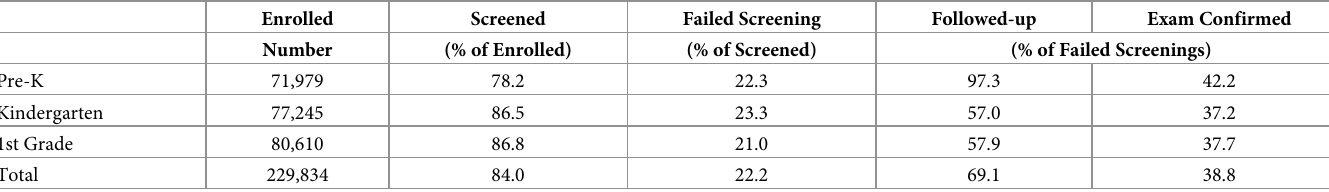
Table 2. Rates of screening, failed screening, follow-up, and confirmed exams in Pre-K to 1 st grade,